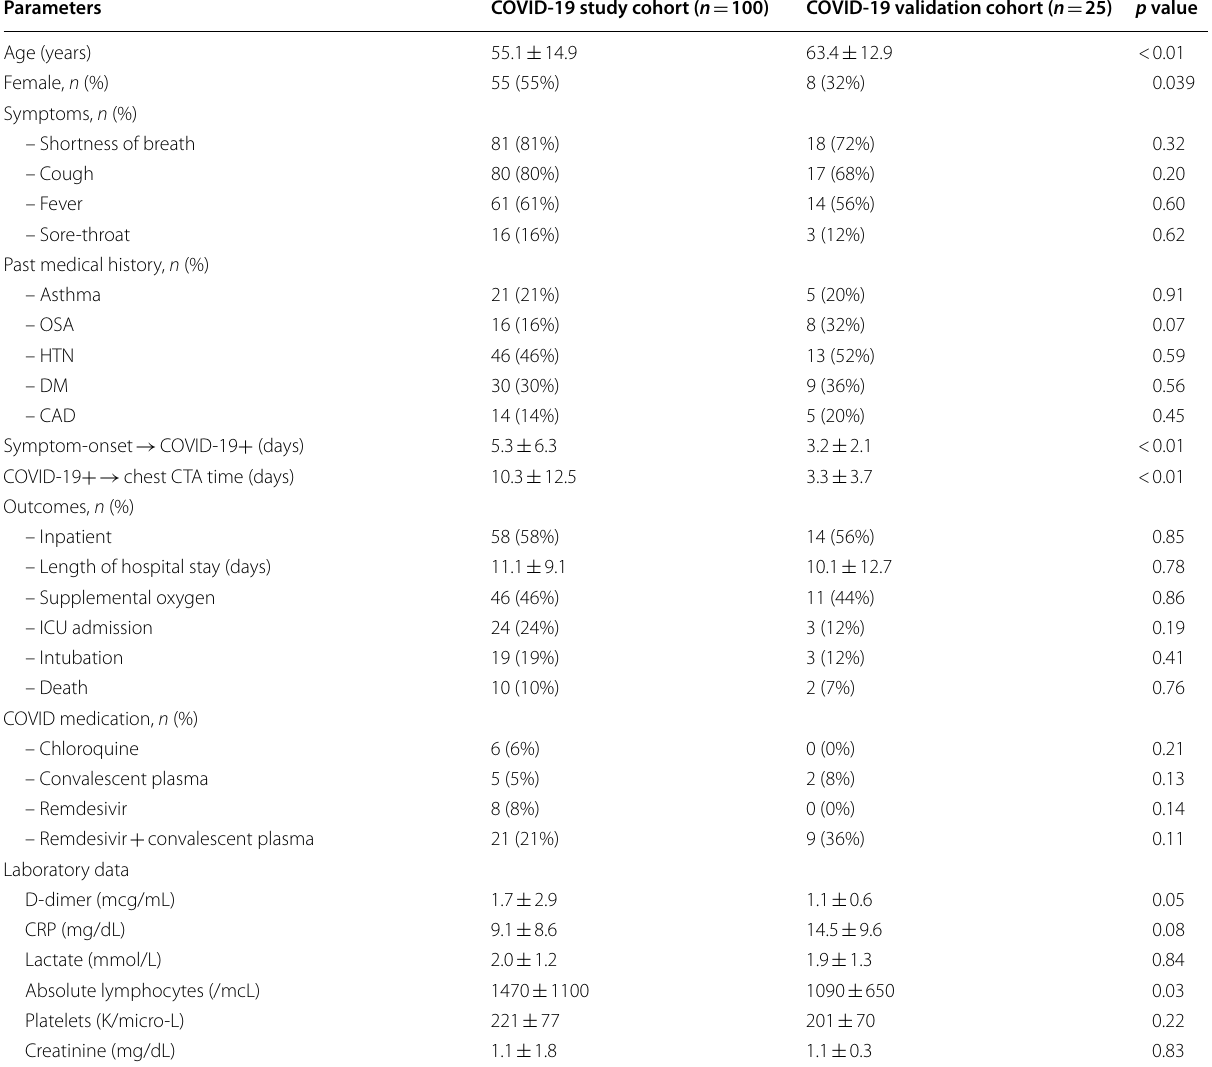
Values are mean